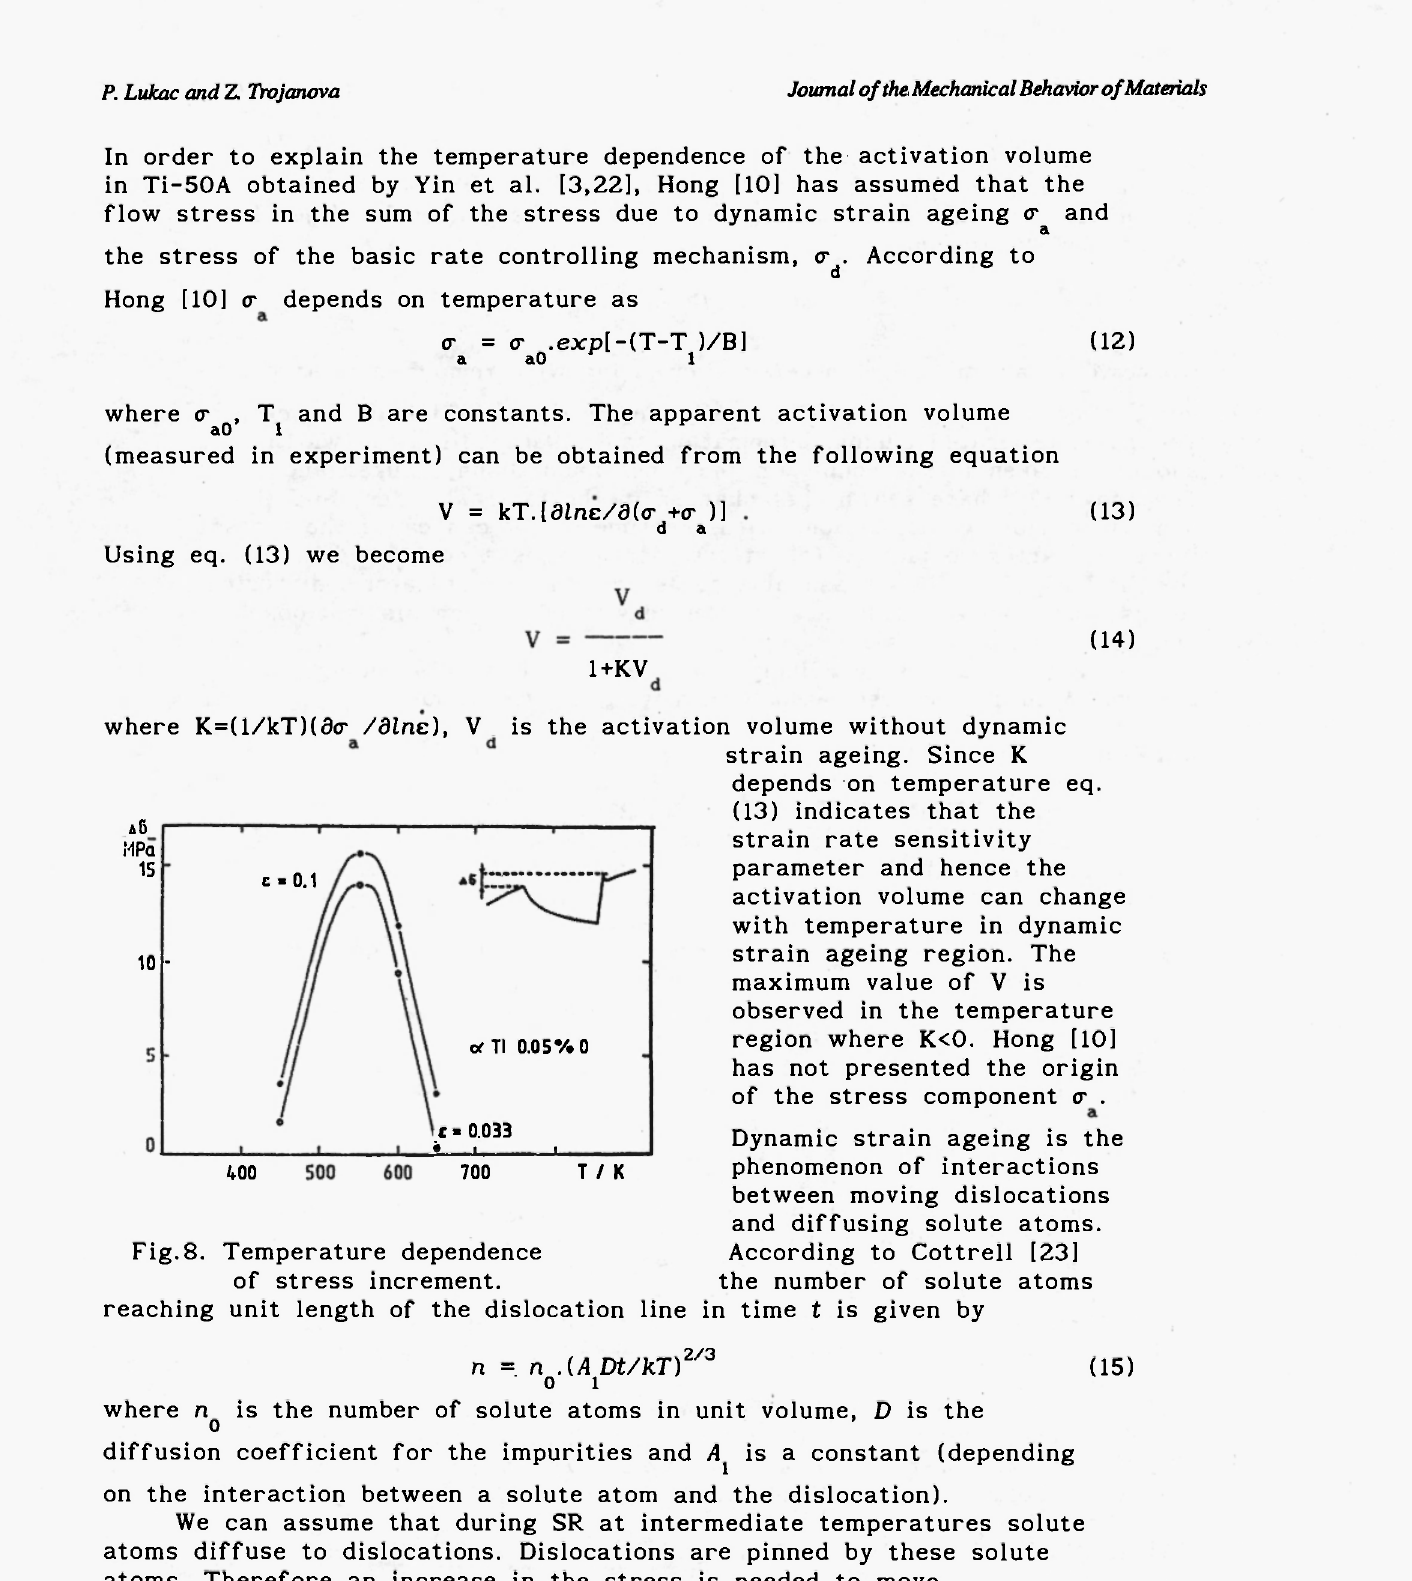
Fig.8. Temperature dependence of stress increment.